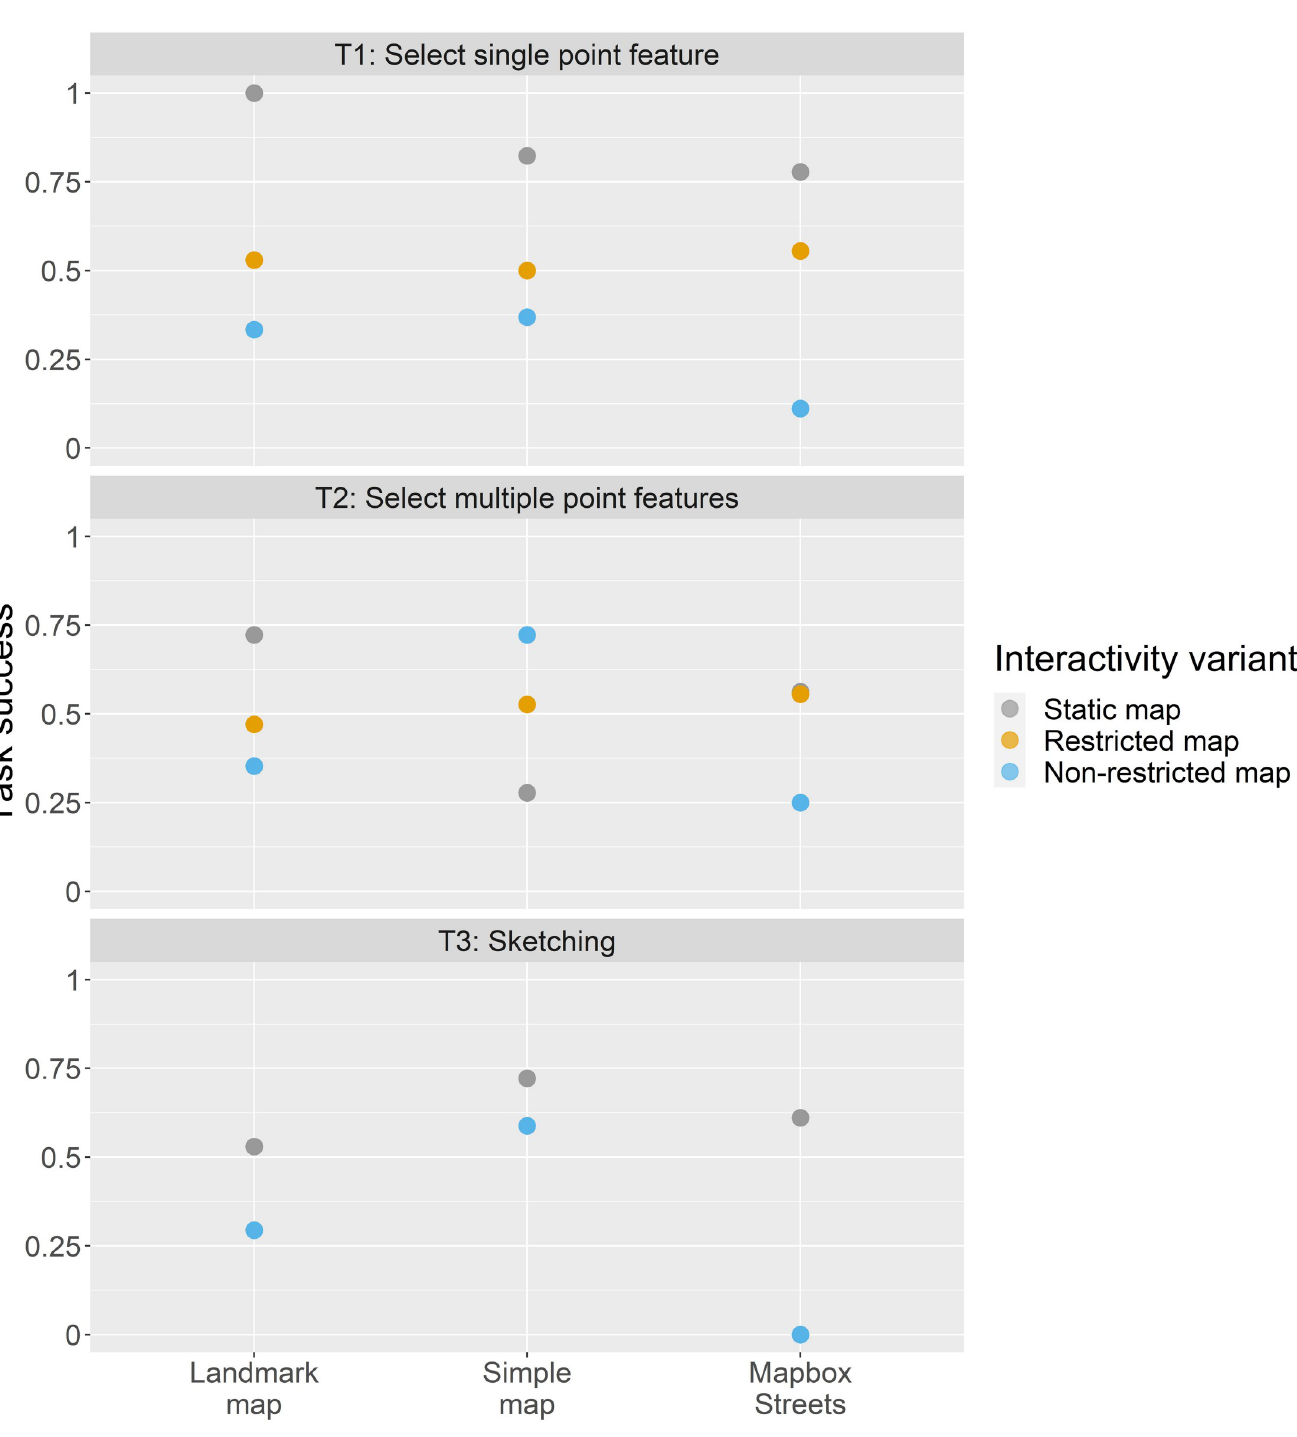
PLOS ONE | https://doi.org/10.1371/journal.pone.0264426 March 2, 2022 12 /